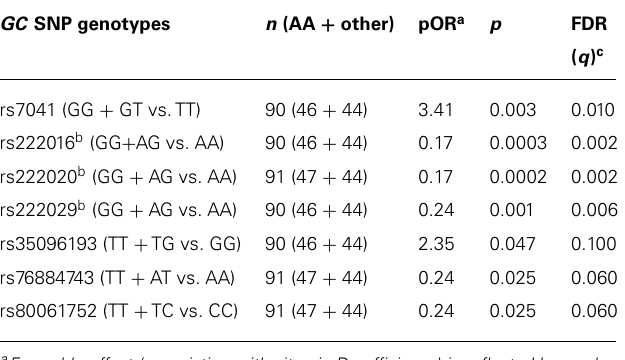
Table 5 | Independent predictors of baseline (week 0) serum 25(OH)D concentration among 192 youth living with HIV-1 infection: alternative analyses after considering environmental factors.